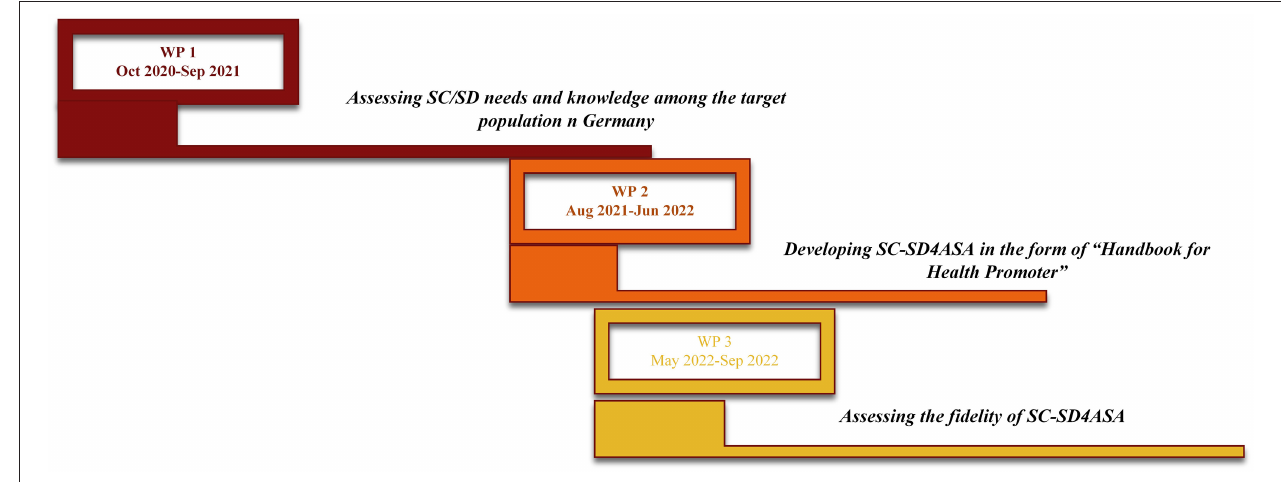
FIGURE 4 | The SC-SD4ASA study